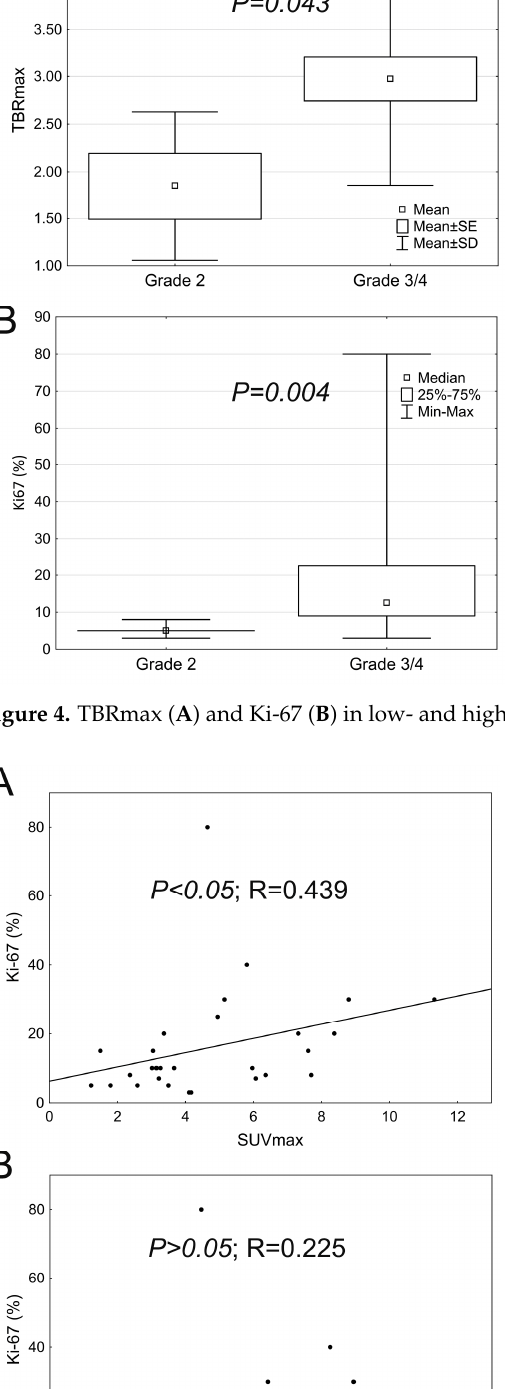
Figure 6. IDH mutation versus TBRmax.